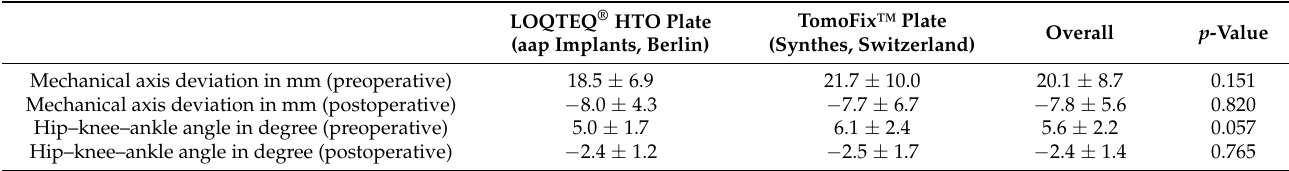
Table 3. Degree of